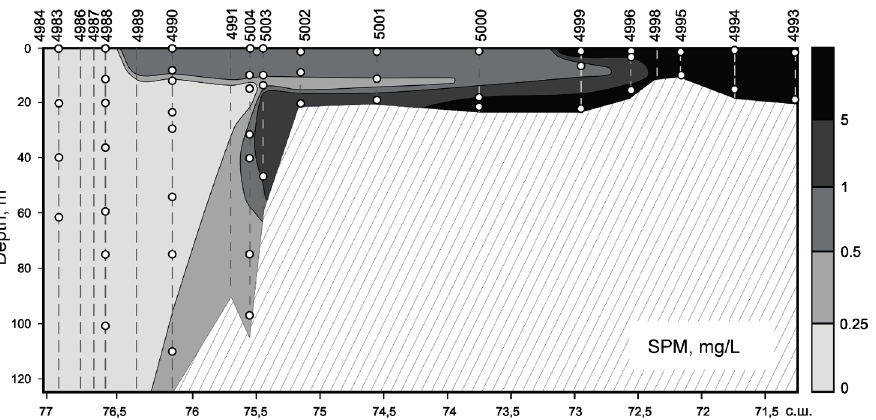
Fig. 3 Distribution of SPM concentration across the shelf along the Ob’ River–St. Anna Trough transect in September 2007 (Burenkov et al . 2010), courtesy Pleiades Publishing, Inc. The circles mark the depth of water sampling. For site locations see Fig.